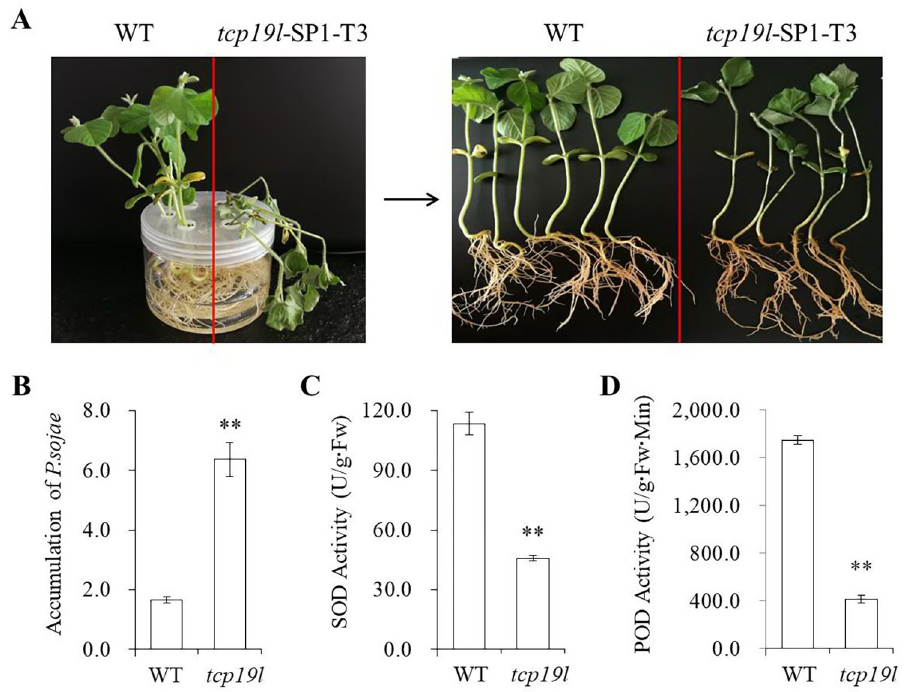
Fig 7. Analysis of the tcp19l -SP1-T3 mutants and WT treated with zoospores of P . sojae in the soybean root hydroponic assay. (A) Disease symptoms on the roots of tcp19l mutants and WT treated with zoospores of P . sojae at 3 days after inoculation. (B) Accumulation of P . sojae in tcp19l mutants and WT. (C, D) The activities of SOD and POD in tcp19l mutants and WT at 3 days after P . sojae inoculation. Three independent biological replicates were used for each sample and the student’s t -test ( � P < 0.05, �� P < 0.01) was used to analyze statistical significance. Error bars represent ± SD.